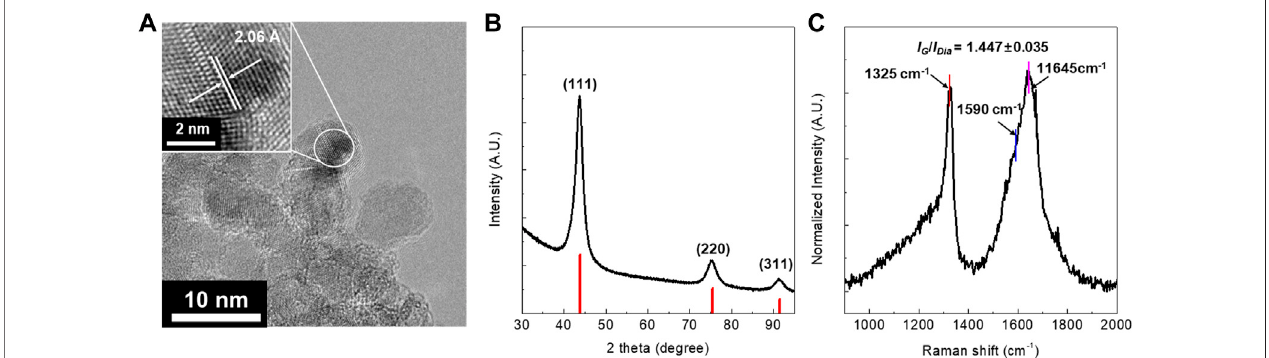
FIGURE1|(A) HR-TEMimage, (B) XRDpatterns, and (C) UV-Ramanspectraofthehighlypuri fi edDNDpreparedbyusingHClO 4 .TheUV-Ramanlaseris325 nm and the intensity ratio was calculated based on I Dia /I G = 1325 cm − 1 /1590 cm − 1